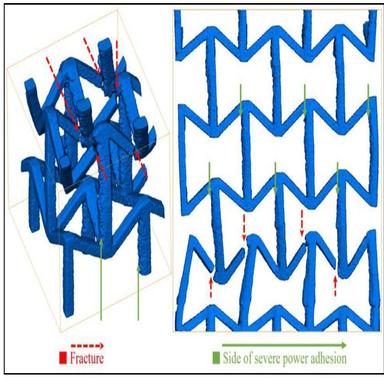
Sub-volumes of the 7th reconstruction model, red dashed arrows indicate the location of fracture and green solid arrows indicate the side of severe powder adhesion.